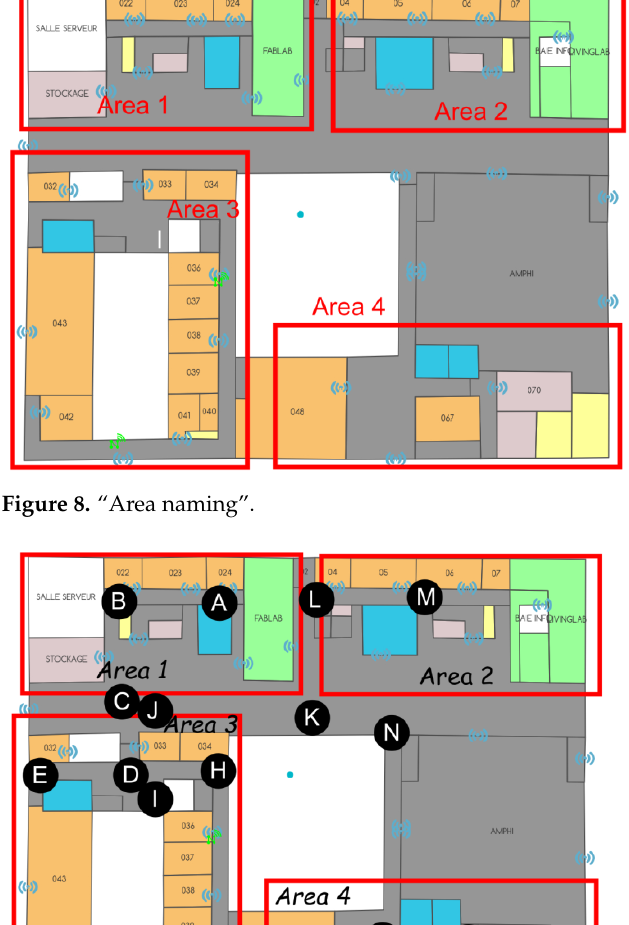
Figure 8. “ Area n aming”.